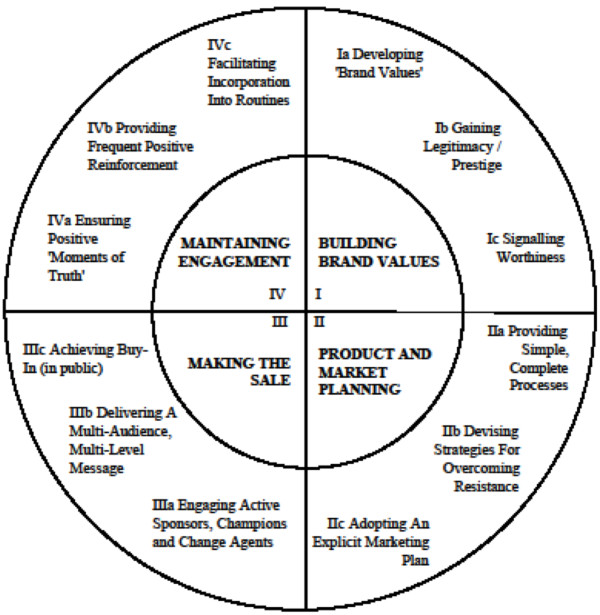
The Francis et al. reference model[9].